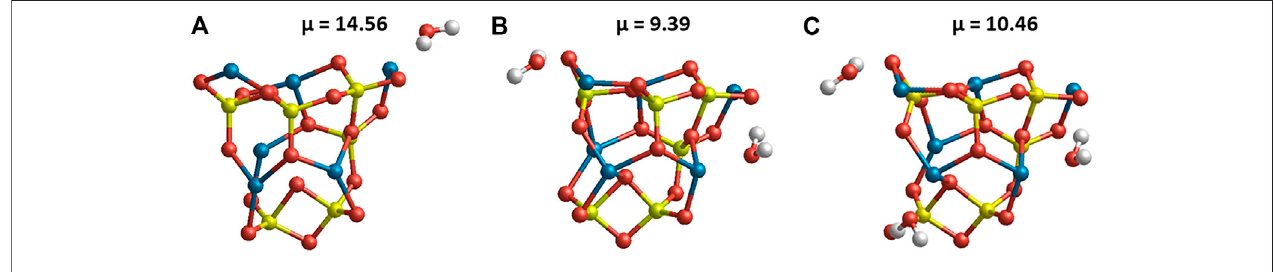
FIGURE 6 | Lowest energy molecularly hydrated (MgSiO 3 ) 6 nanosilicate structures starting from the high dipole (see Figure 1B ) bare structure with (A) one, (B) two, and (C) three water molecules. Dipole moments for each nanocluster are given in Debyes. Atom color key: silicon – yellow, magnesium – blue, and oxygen —